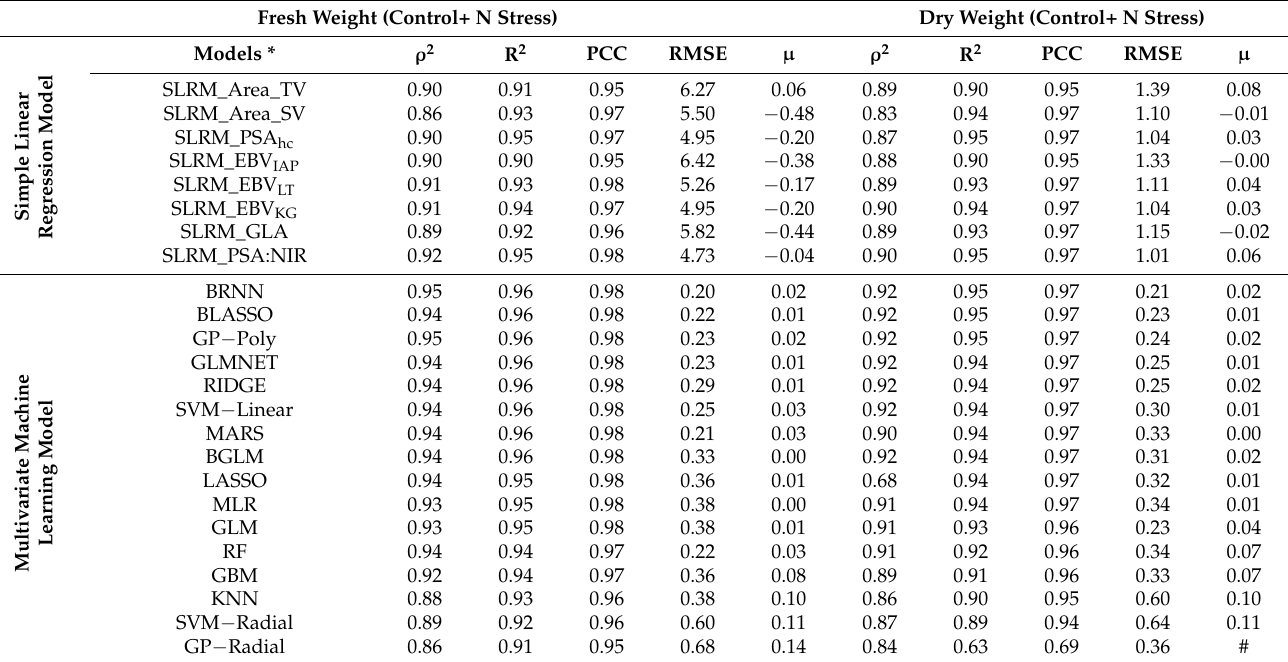
Table 1. Comparative evaluation of simple and multivariate machine learning model in predicting BIOMASS in